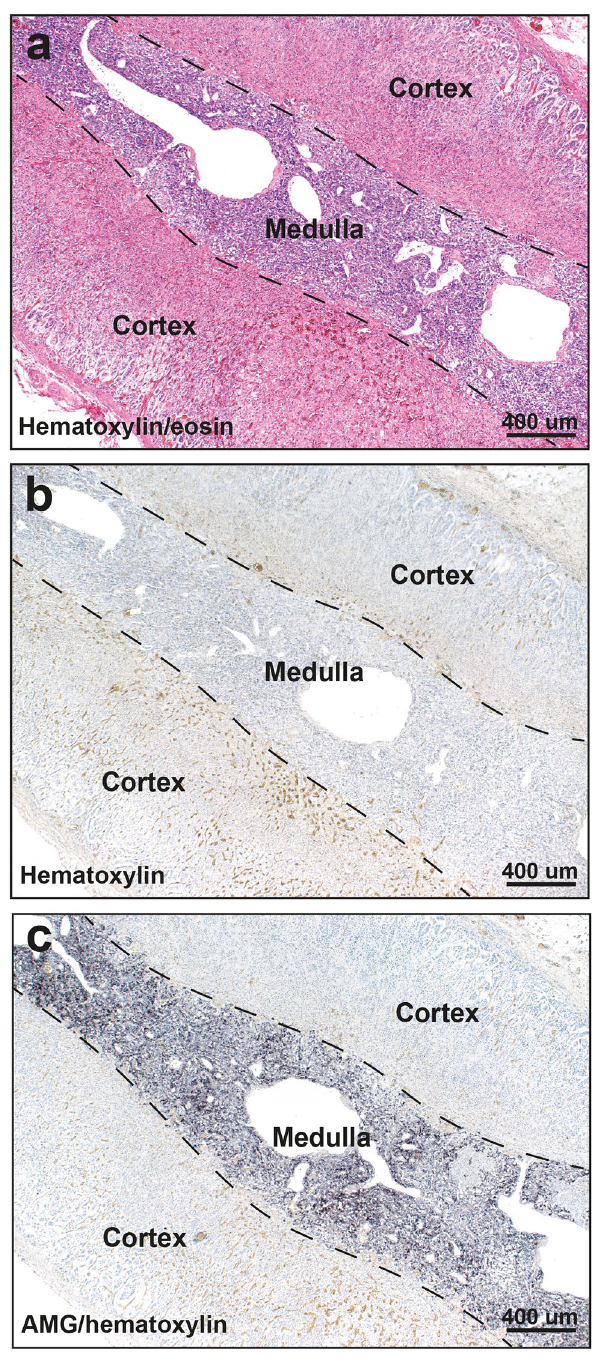
Figure 2. Routine and AMG staining of an AMG-positive adrenal medulla. All adjacent sections are from the same sample (from a 39 year-old male). ( a ) No histological abnormalities are seen in the adrenal cortex or medulla on hematoxylin and eosin staining. The medullary chromaffin cells have a bluish tinge. The large spaces in the medulla are empty veins. ( b ) No black grains are present in the adrenal cortex or medulla in a section stained with hematoxylin only. The yellow in the cortex shows erythrocytes. ( c ) Black AMG staining is seen in the adrenal medulla, but not in the cortex, in a section stained with AMG and